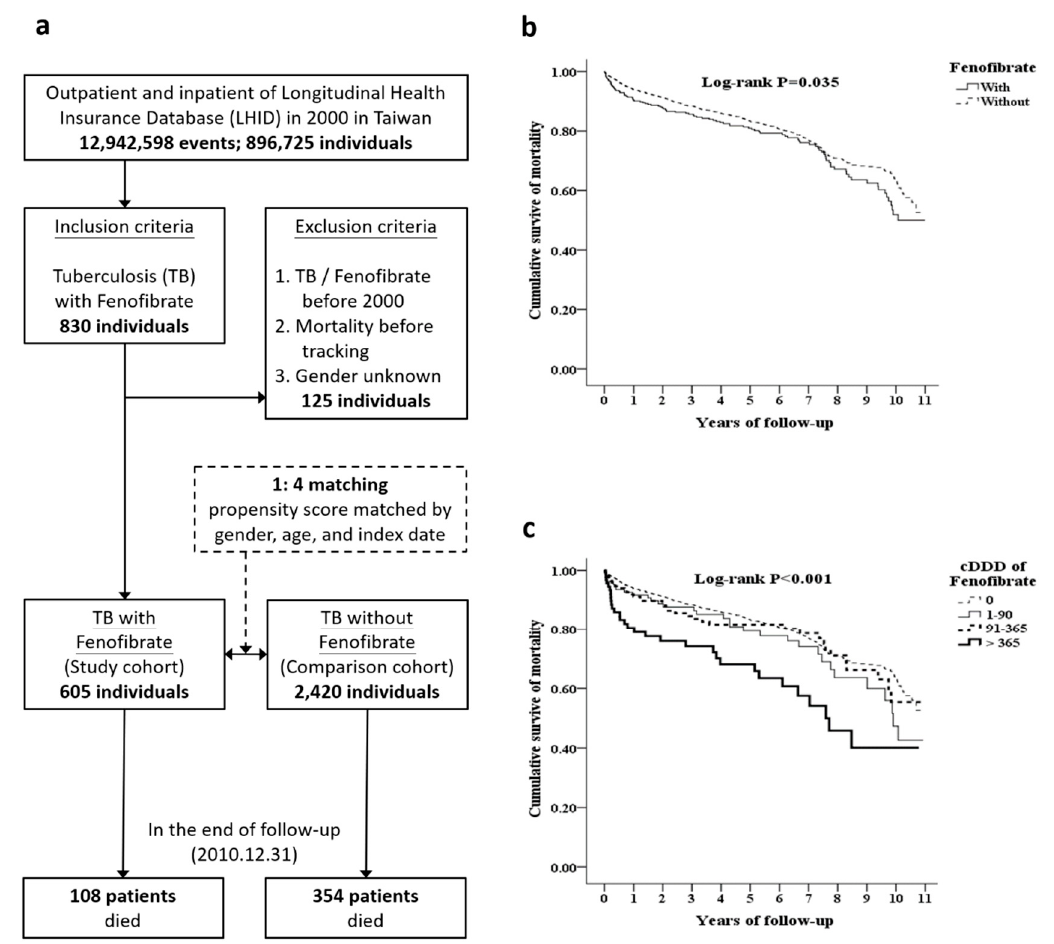
Figure 1. Outcome of tuberculosis (TB) patients on fenofibrate therapy from the National Health